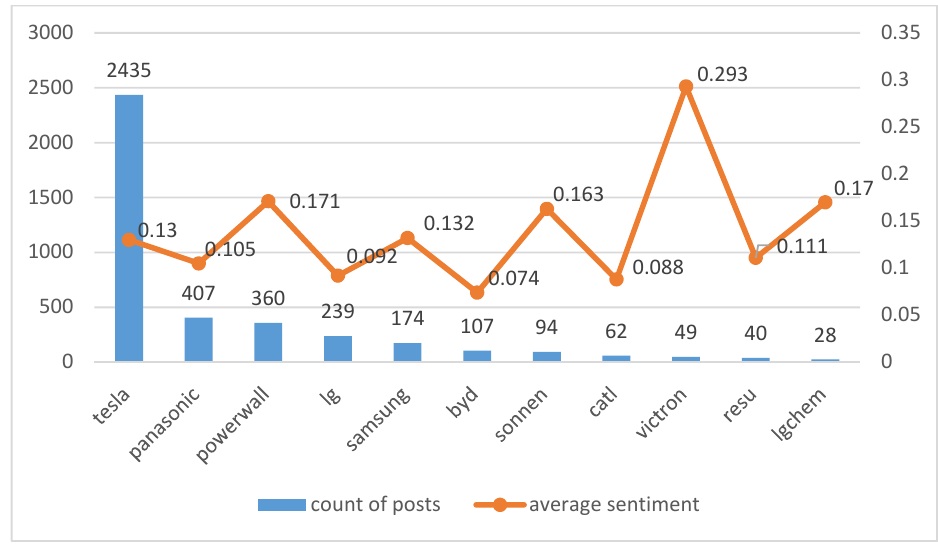
Figure 8. Number of mentions of the biggest battery manufacturers and their sentiment scores.